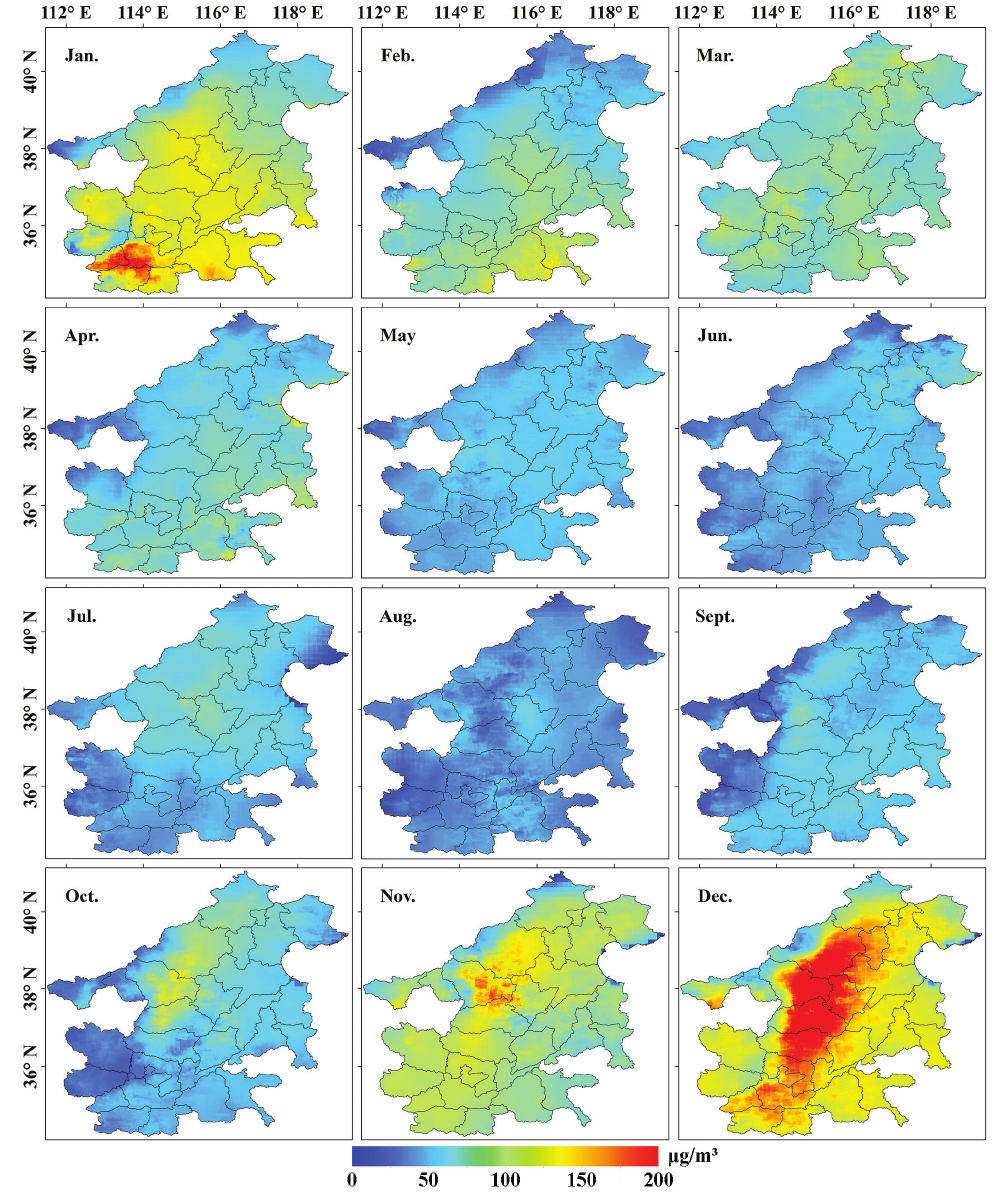
Figure 5. Spatial distribution of MAPC in each month of 2016.